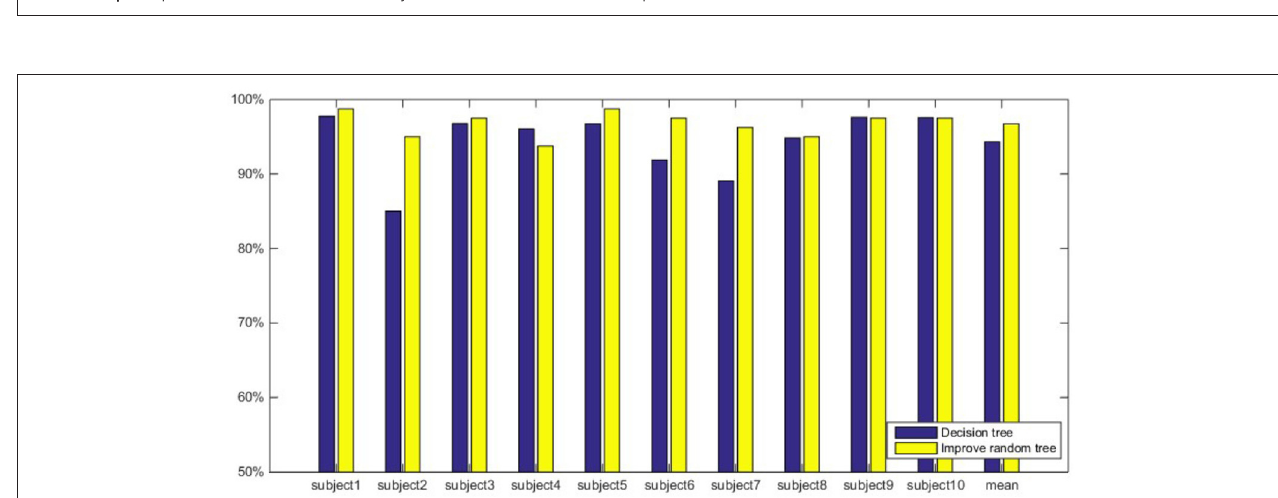
FIGURE 6 | Comparison of classification accuracy of two classifiers based on MSpEn.